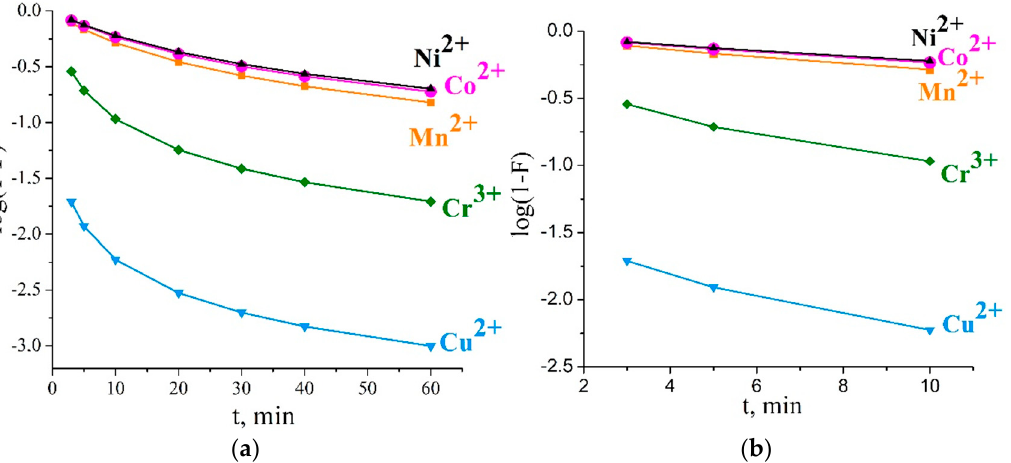
Figure 3. Film diffusion kinetics plots for Cu 2+ , Co 2+ , Ni 2+ , Mn 2+ , and Cr 3+ sorption on Li-TiOP at 298 K for contact times of 60 min ( a ) and 10 min ( b ).